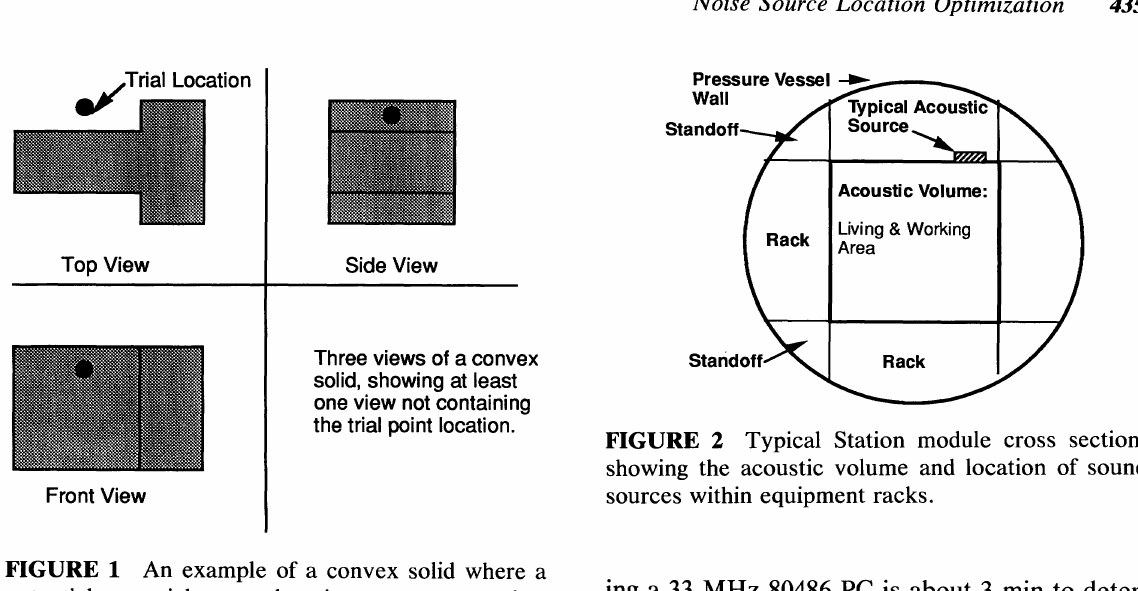
FIGURE 1 An example of a convex solid where a potential new trial source location occurs external to the acoustic volume. In at least one view, the point is located outside the projection. This can be detected by determining the background color at the plotted trial point location.